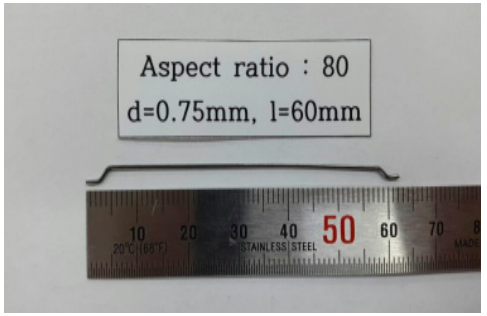
Figure 1. Shape of used steel fiber.